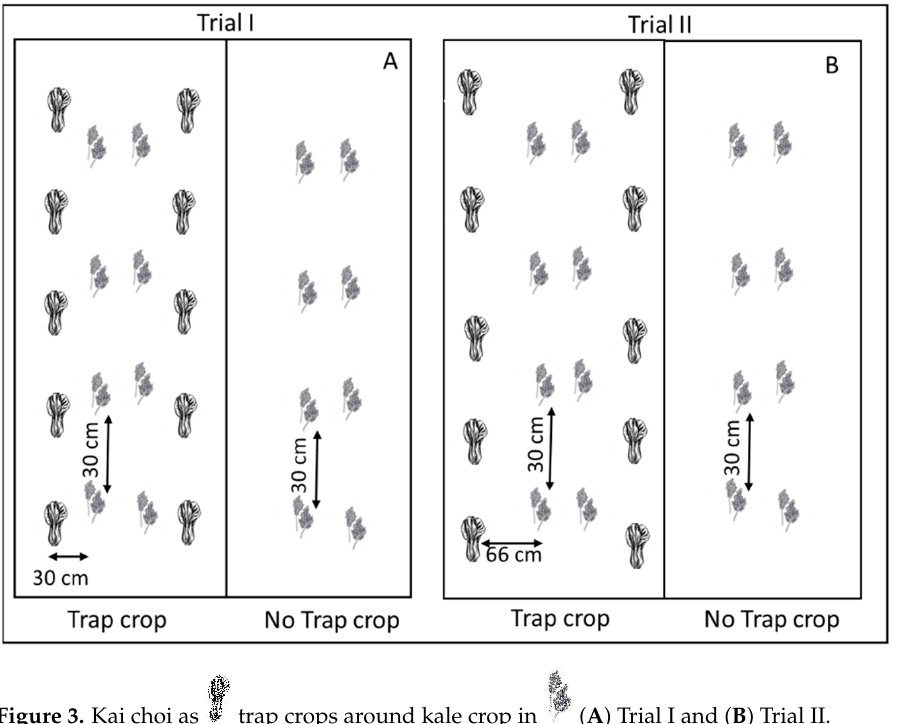
Figure 3. Kai choi as trap crops around kale crop in ( A ) Trial I and ( B ) Trial II. Four randomly selected plants were recorded from each plot for (1) percentage of leaves with DBM or ICW damage, and (2) abundance of eggs, larvae, pupae, and adult stages of DBM and ICW per plant weekly for 5 weeks. Kale leaves were harvested weekly starting from the third to fifth weeks after transplanting.